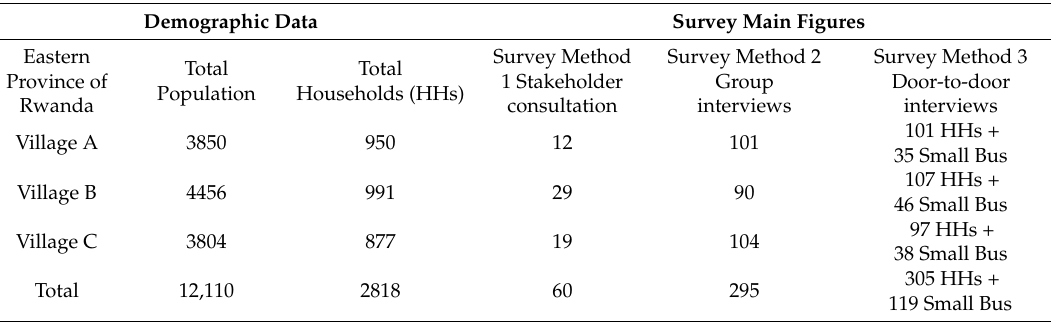
Table 1. Main survey figures of the data